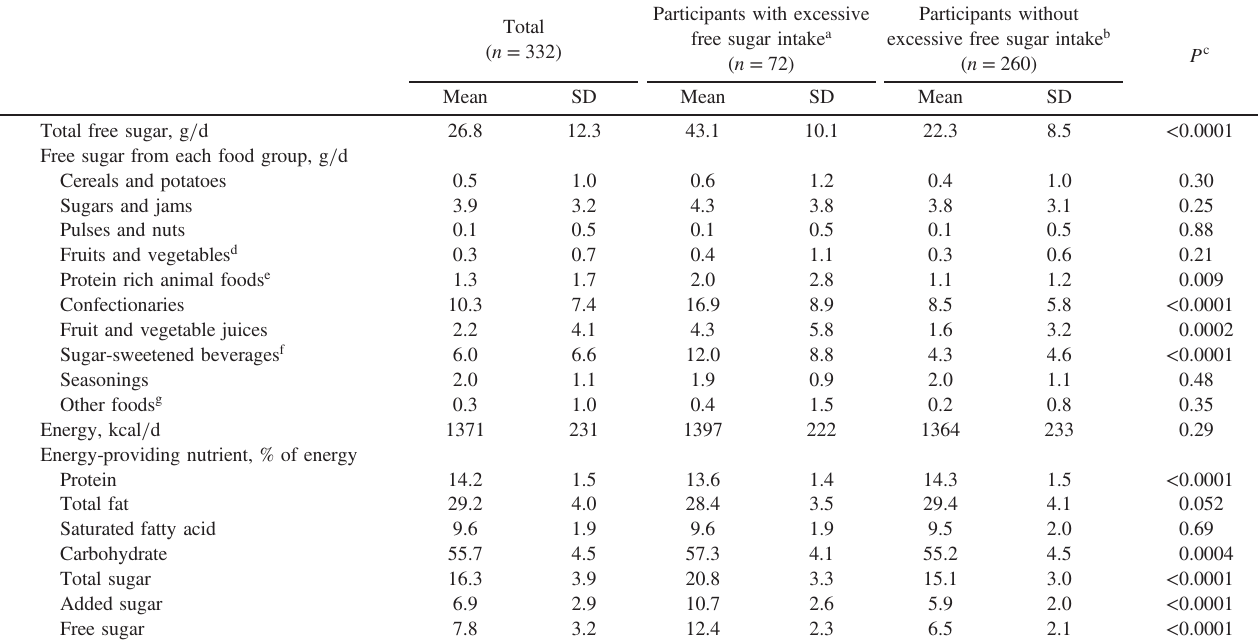
Table 3. Dietary intake in Japanese children aged 3 – 6 years ( n = 332)